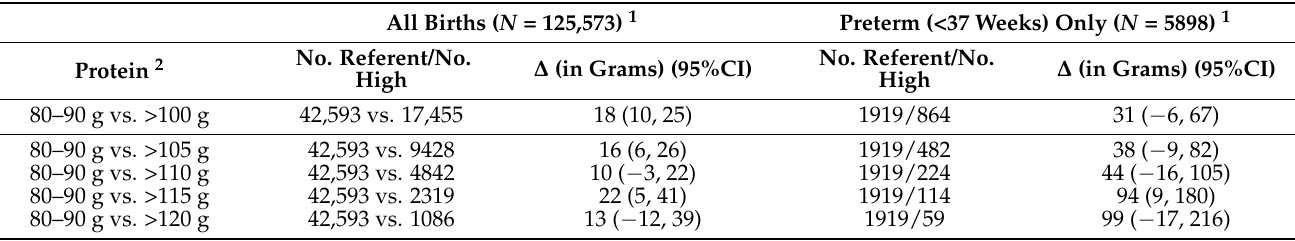
Table 4. Extreme protein intake in relation to birth weight among all infants and preterm infants only. Mean differences ( ∆ ) in birth weight across categories of protein intake relative to the reference (80–90 g) category are shown. The Danish National Birth Cohort (DNBC, 1996–2002) and the Norwegian Mother, Father and Child Cohort study (MoBa, 2002–2008). All Births ( N = 125,573) 1